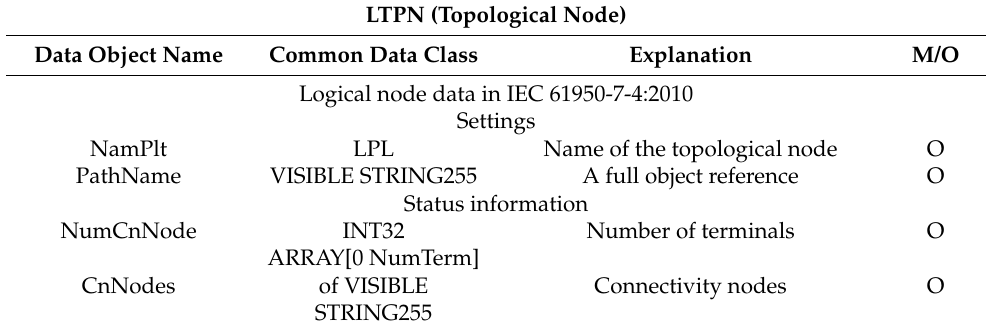
Table 4. Logical node